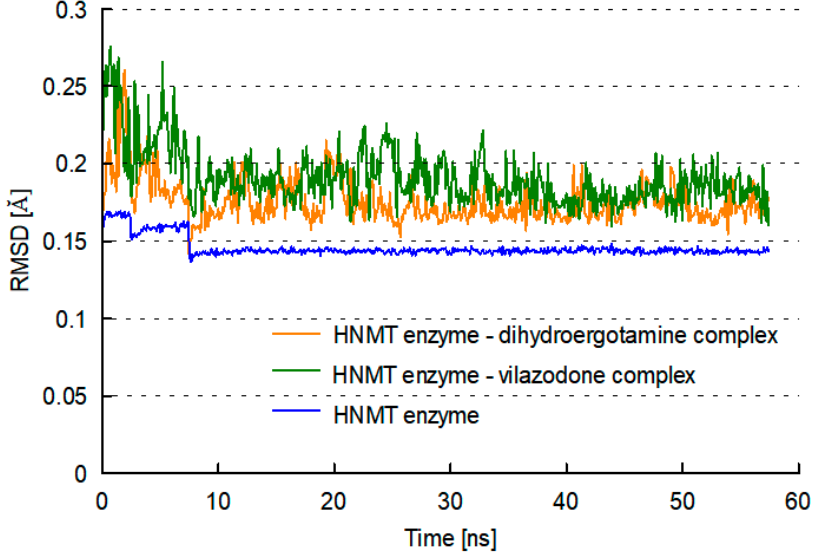
Figure 4. Root-mean-square deviation (RMSD) values for the HNMT–ligand complex obtained during MD simulations; HNMT protein backbone (blue line), HNMT–vilazodone complex (green line) and HNMT–dihydroergotamine complex (orange line).